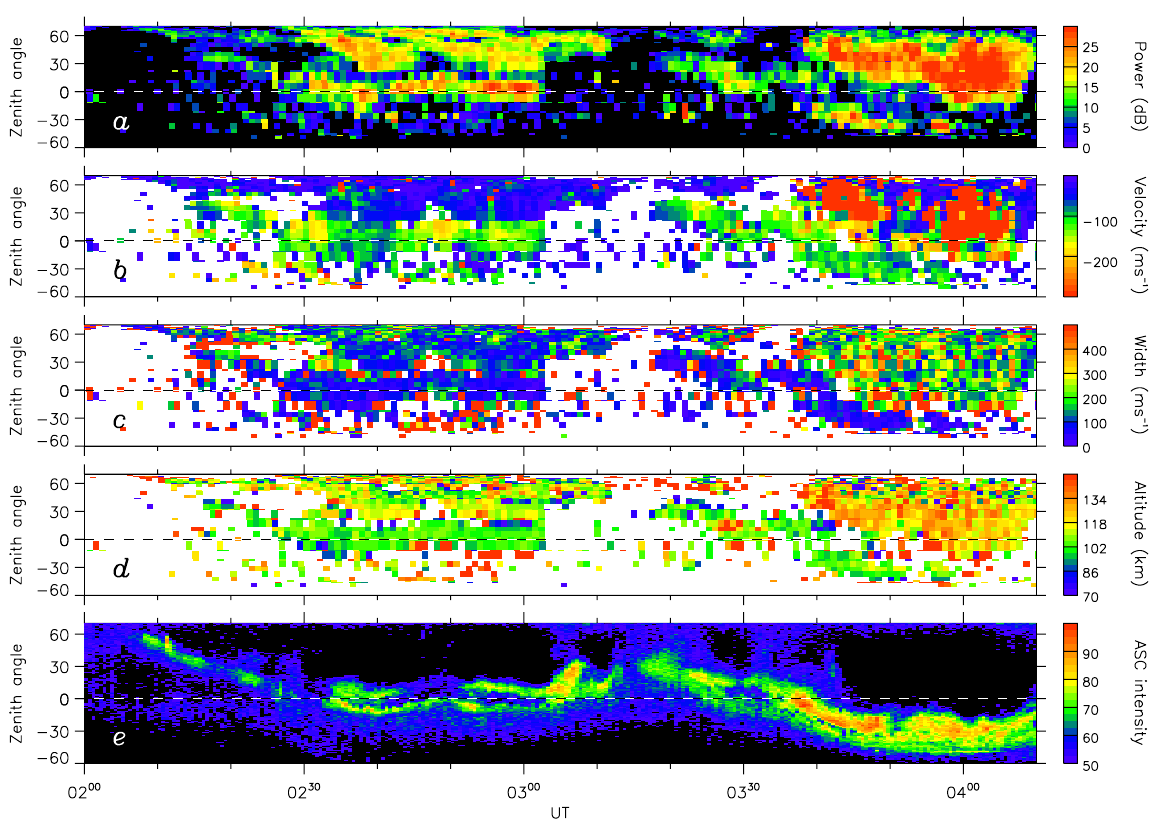
Fig. 4. Radar keograms of (a) backscatter power or signal-to-noise ratio, (b) Doppler shift or line-of-sight velocity, (c) spectral width, and (d) estimate of altitude of scatter volume. (e) Keogram of the visual